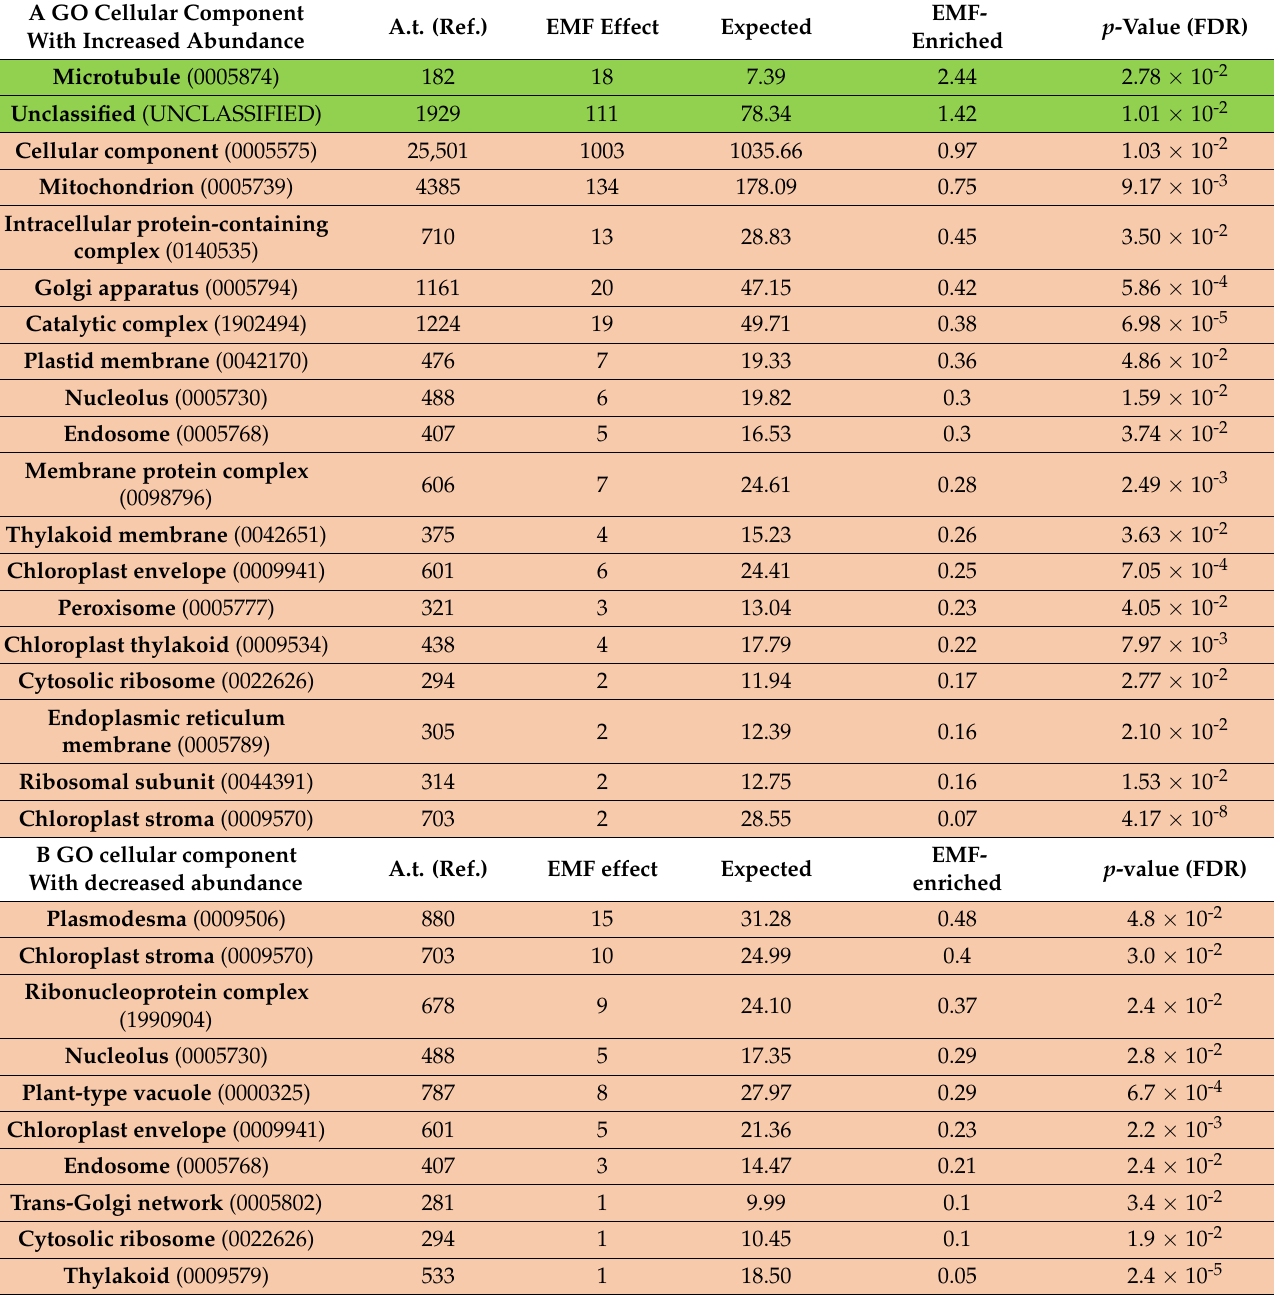
Table 1. Gene ontology (GO) analysis of EMF-induced transcript changes. ( A ) All 1114 unique transcripts with fold change higher than 2-fold were considered for the analysis. ( B ) All 975 unique transcripts with fold change values < 0.50 were included in the analysis. The table gives the GO term description, the number of transcripts belonging to the group (Ref.), the number affected by EMF, the expected and observed enrichment, and the corrected p